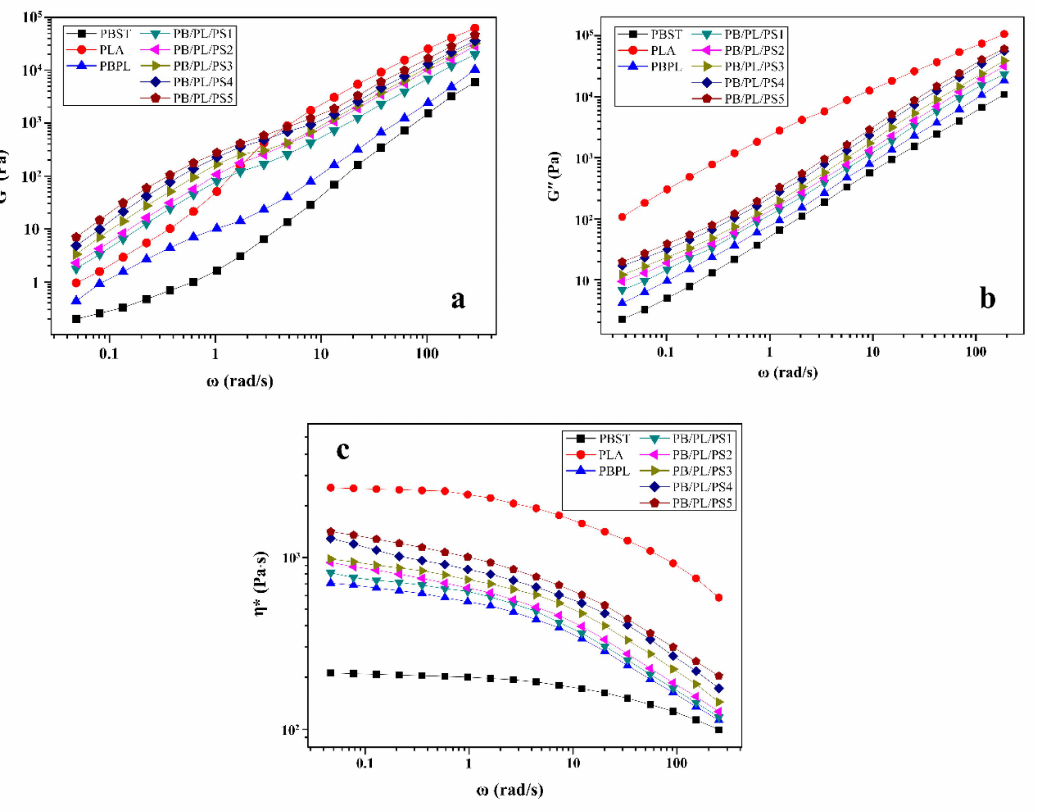
Figure 8. Curves of dynamic frequency sweep for neat PBST, PLA, and PBST/PLA blends with various amounts of PSMA: ( a ) G (cid:48) , ( b ) G (cid:48)(cid:48) , and ( c ) η